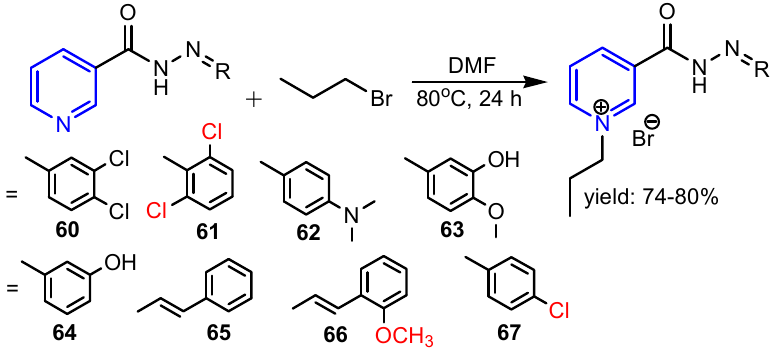
Scheme 11. Synthesis of pyridine salts 60 − 67 [33]. Soukup et al. [34] synthesized five series of pyridinium salts 68a − 68c , 69a − 69c , 70a − 70c, 71a − 71c and 72a − 72c via an S N 2 type Menshutkin reaction (Figure 4) with yields of 81–98%. Compound 72c showed a rather versatile efficacy against the whole spectrum of microbes, three Gram-positive ( S. aureus C1947, methicillin-resistant S. aureus MRSA